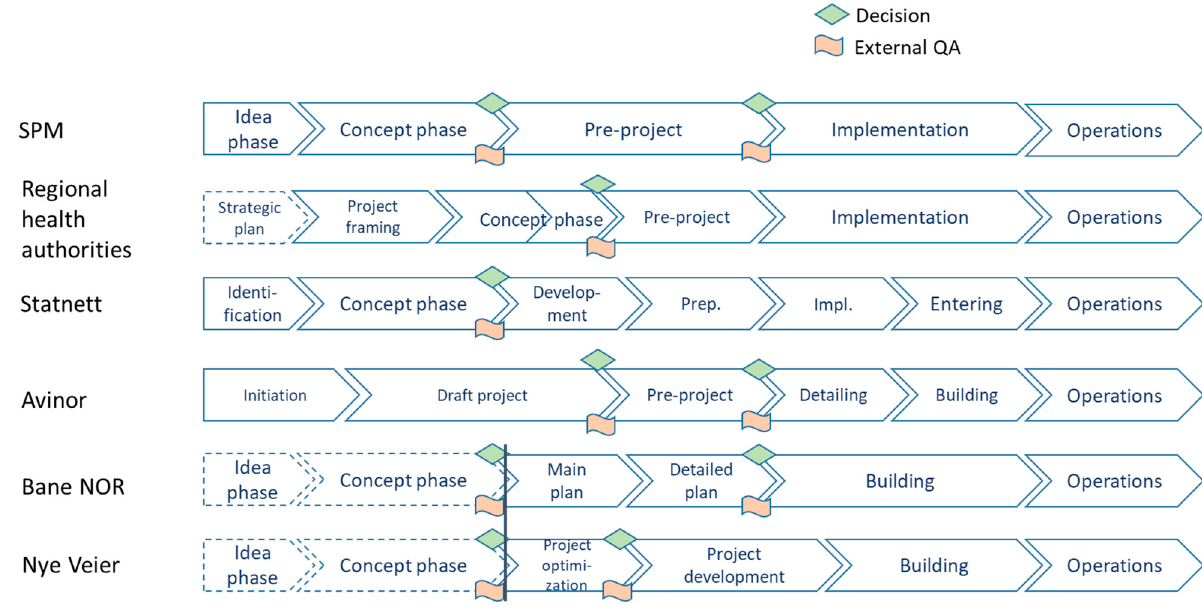
Figure 4. The stage-gate models for project governance for the case SOEs and the Norwegian State, showing the different project phases, when external QA is performed and different decision points.